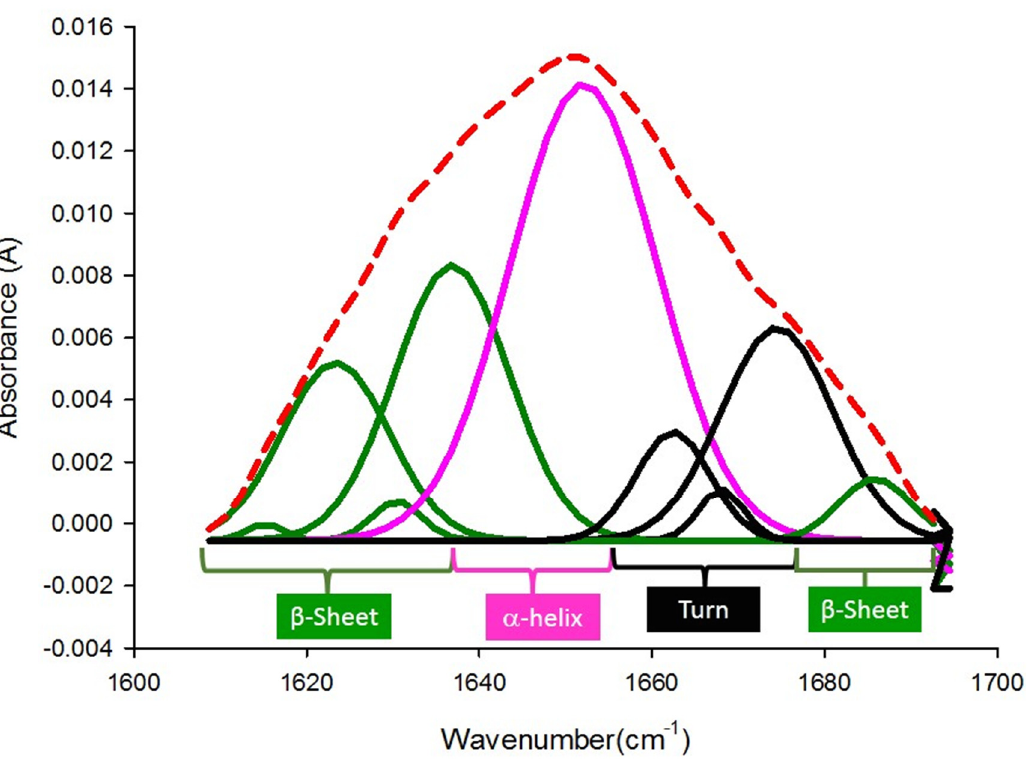
Figure 2. FT-IR spectra of pericarp for the amide band I region, which represents peak-fitting of the second derivative curves of the spectra.